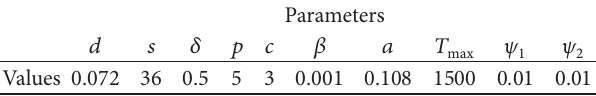
Table 1: The values of the parameters in the HBV dynamics model. Parameters 𝑑 𝑠